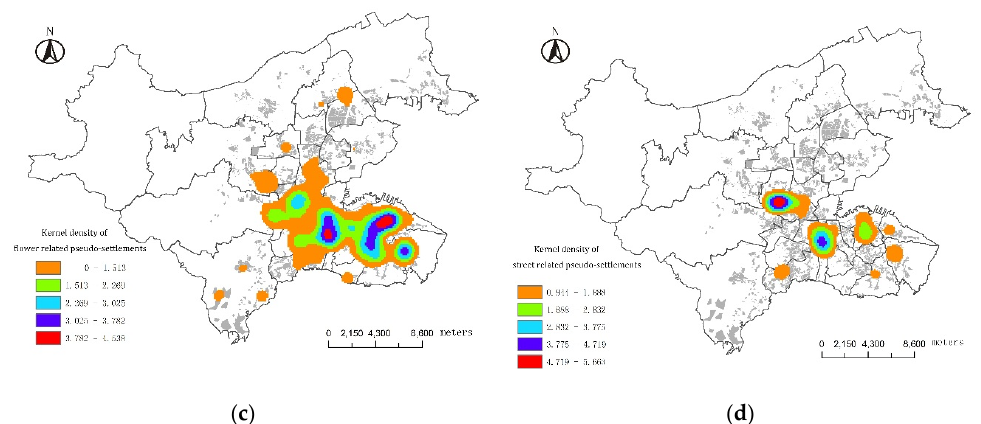
Figure 3. Spatial features of the pseudo ‐ environment of human settlements in Dalian. ( a ) Water ‐ related pseudo ‐ settlements; ( b ) Mountain ‐ related pseudo ‐ settlements; ( c ) Flower ‐ related pseudo ‐ settlements; ( d ) Street ‐ related pseudo ‐ settlements.